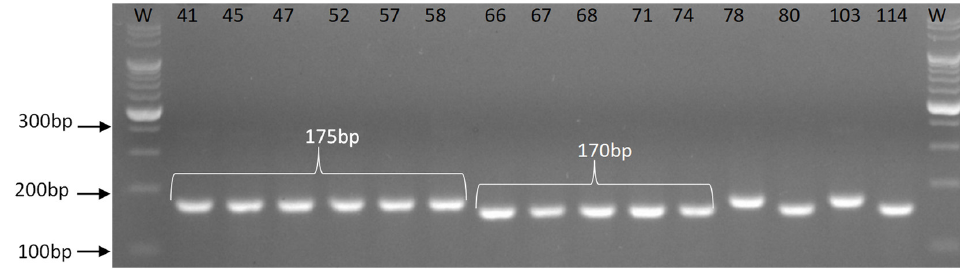
Figure 2. Electrophoretic image of PCR products in 2% agarose gel using bnlg1621 primer pair.